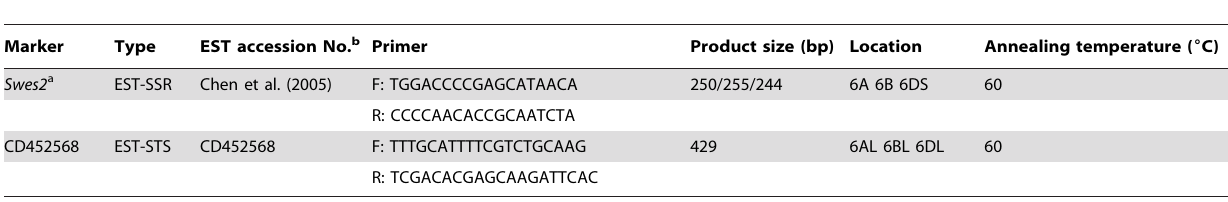
Table 3. Primers used to produce specific markers for chromosome 6Ns in Psathyrostachys huashanica.